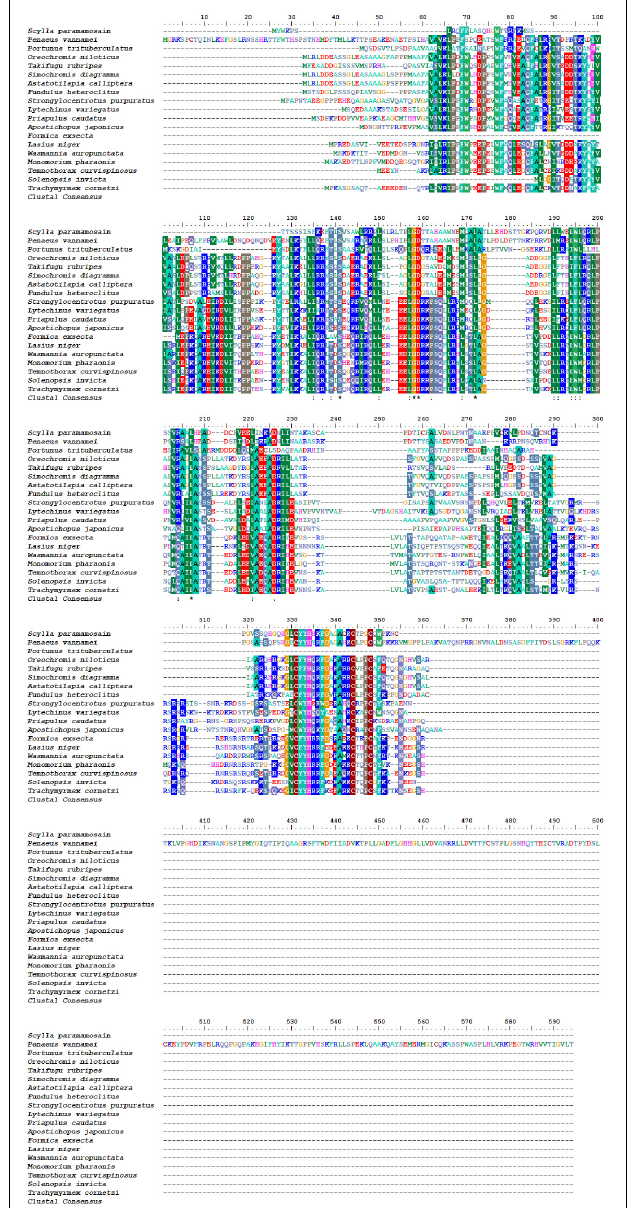
FIGURE 4 | Multiple alignments of deduced amino acids of Sp-Pol protein and its homologs. GenBank accession numbers are as follows: Penaeus vannamei (ROT64510.1); Portunustri tuberculatus